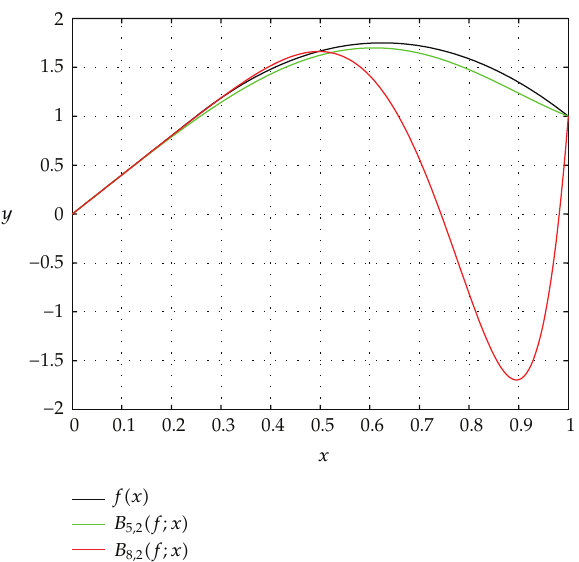
Figure 3: Graphs of y (cid:6) f (cid:2) x (cid:3) and y (cid:6) B n, 2 (cid:2) f ; x (cid:3) , n (cid:6) 5 ,